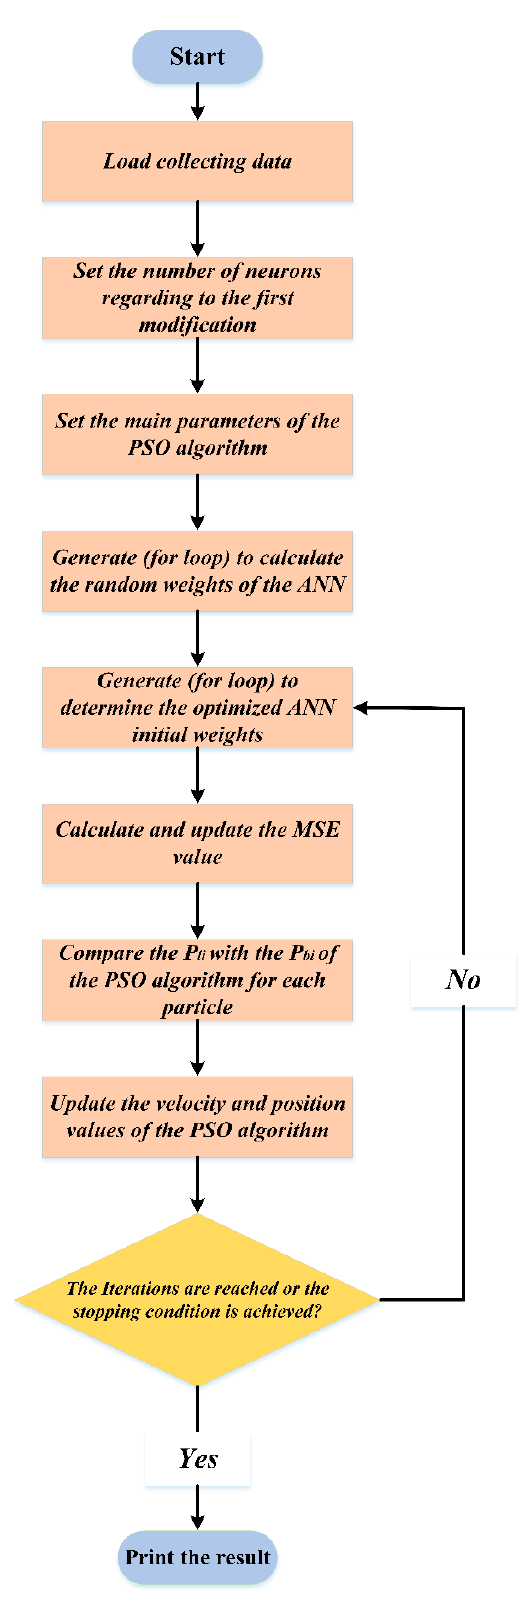
Figure 11. The second proposed algorithm to find the initial neurons of the ANN model.